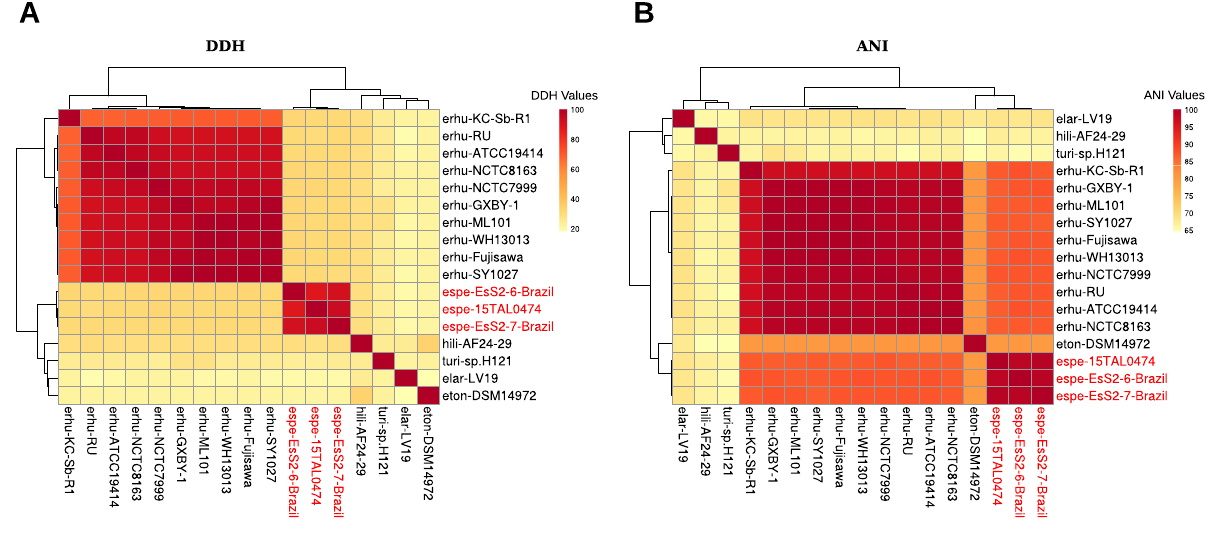
Figure 3. Heatmap of whole-genome sequence pairwise comparisons between species of the genus Erysipelothrix and two outgroups. Legend: ( A ) Heatmap of the digital DNA:DNA hybridizations (dDDH). ( B ) Heatmap of the Average Nucleotide Identity (ANI). The percentages are provided in Supplementary Table S3. Species mentioned in the figures are described Supplementary Table